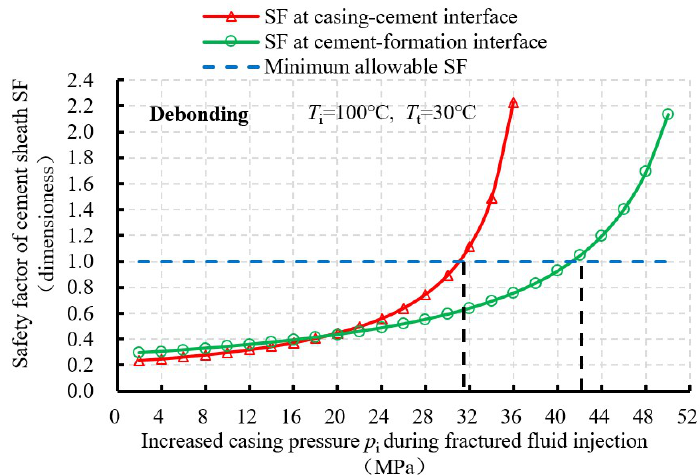
Figure 6. Safety factor of cement sheath for de-bonding at two interfaces under different increased casing pressures p i and decreased temperature of 70 °C at the casing inner wall.